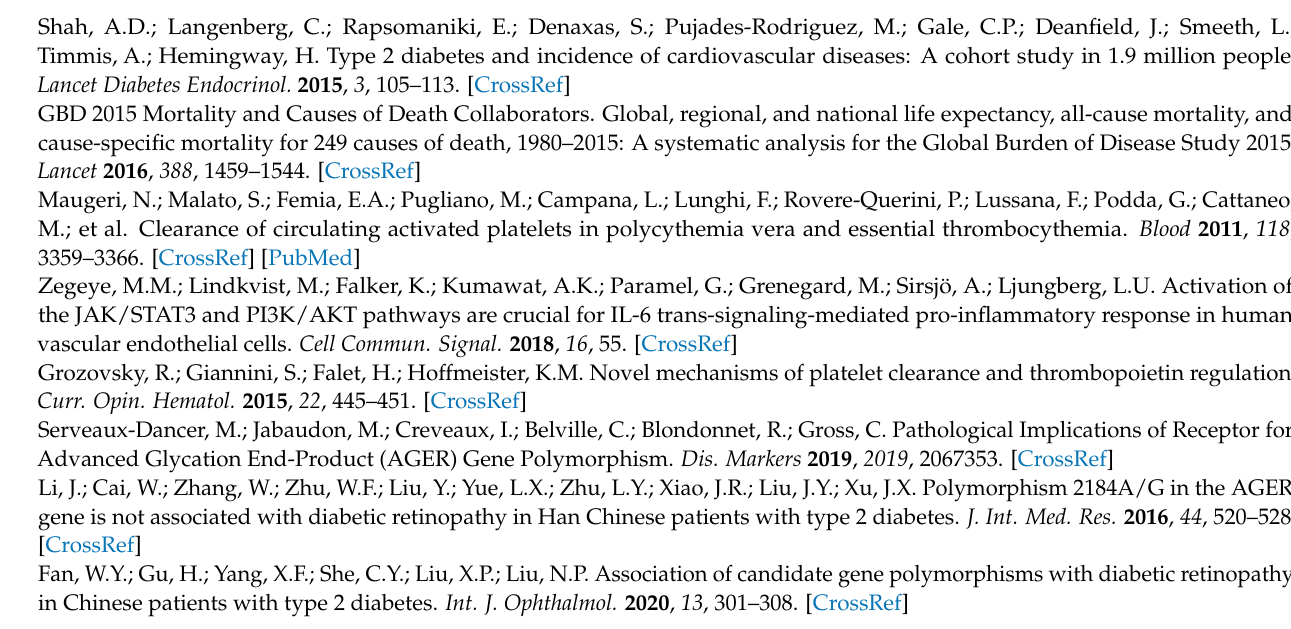
Table S6: The association between candidate SNPs and FPG or ICVD risk scores; Table S7: The association of traits and haplotypes constituted by rs184003-rs1035798-rs2070600-rs1800624; Table S8: The association of traits and haplotypes constituted by rs7529229-rs4845625-rs4129267-rs7514452- rs4072391; Table S9: The function of AGER and IL6R polymorphisms. References [50–66] are cited in the supplementary